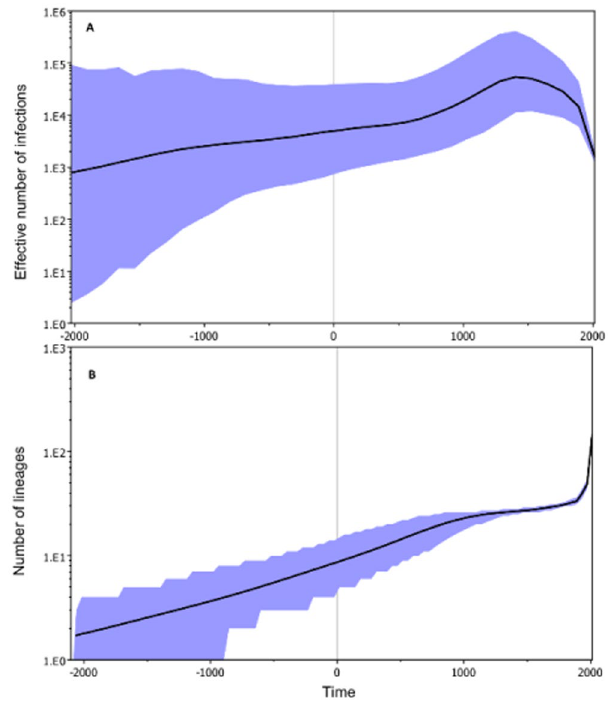
Figure 3. Bayesian skygrid plots (BSP), inferred from partial L - gene , for Rodentia associated UMRV . BSP depict viral population dynamics and the changing levels of genetic diversity ( A ) and the effective number of viral lineages ( B ) (y axis; log10 scale) over time (x axis; calendar years) for Rodentia associated UMRV lineages, showing the median estimate (solid line) and credibility interval (blue area). The vertical dotted line represents the upper limit of the root height, with the mean T MRCA at the